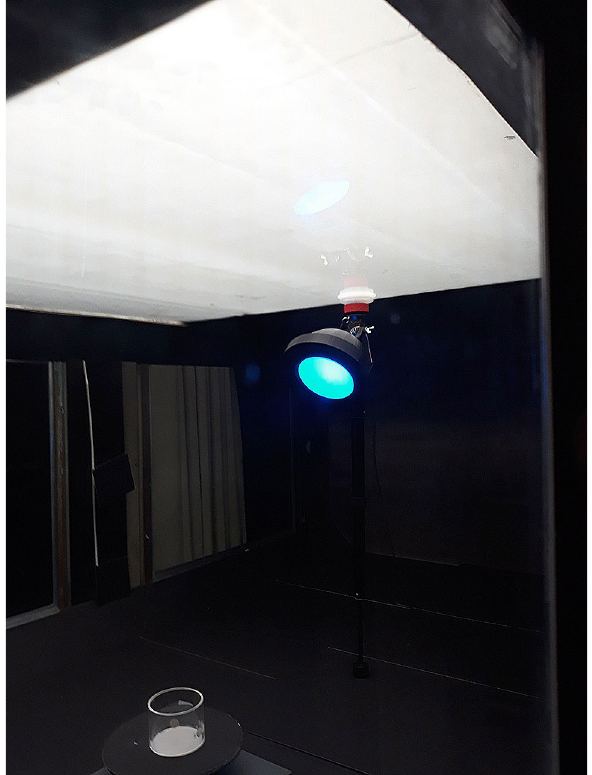
Figure 1. Wind tunnel setting of LED testing. The roof light (white top) is prevented from reflecting light on the glass plate of the cone (yellow LED shining through the glass plate) by facing 45°